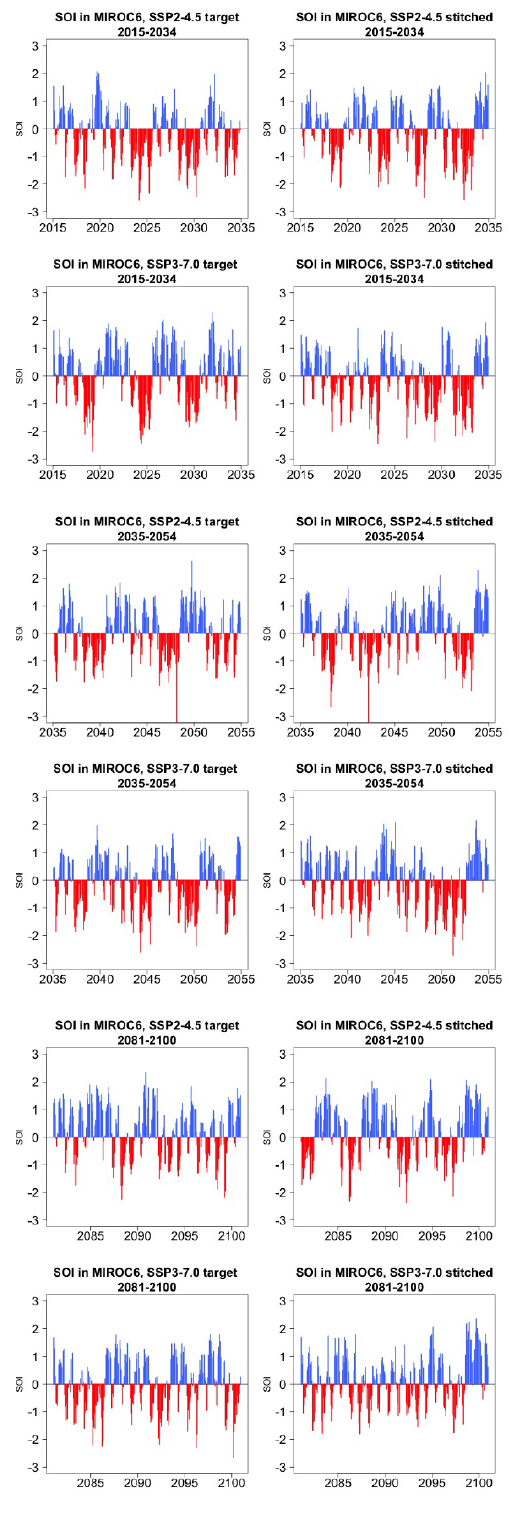
Earth Syst. Dynam., 13, 1557–1609, 2022